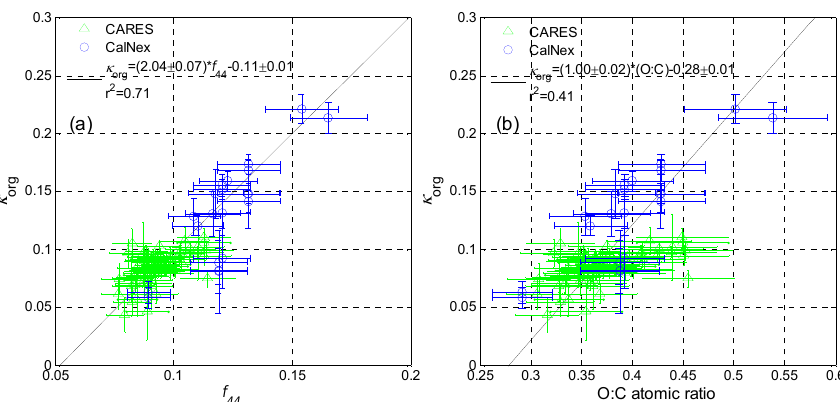
Fig. 4. Derived κ org as a function of (a) f 44 and (b) O:C atomic ratio and least squares fits.